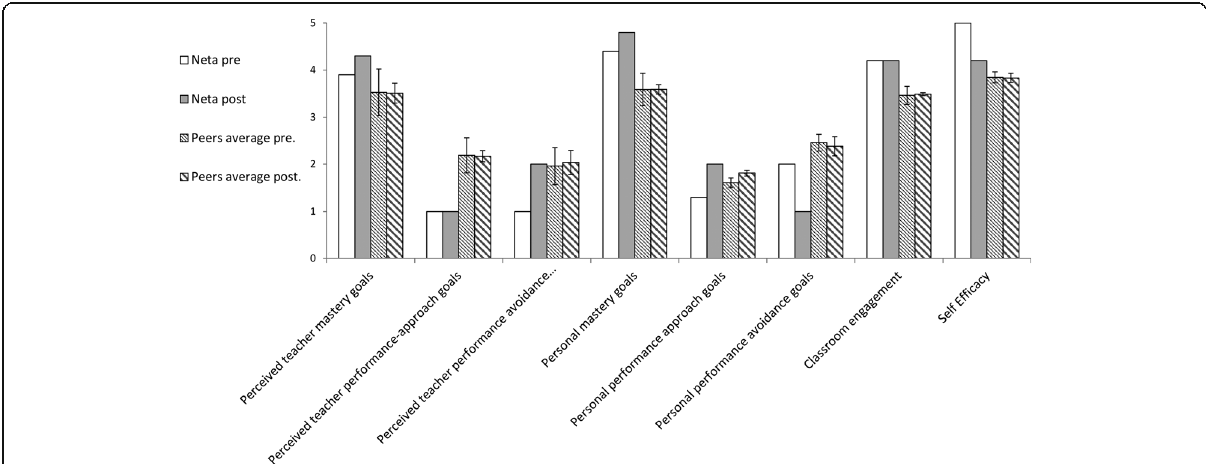
Fig. 2 Comparing Neta ’ s Motivational Characteristics With Those of Her